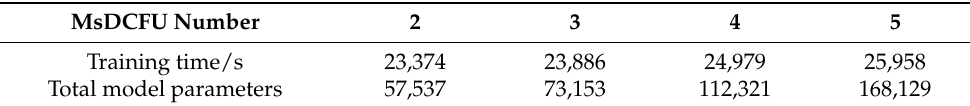
Figure 11. Evaluation indexes based on different convolution kernel sizes: ( a ) RMSE and ( b ) SF.